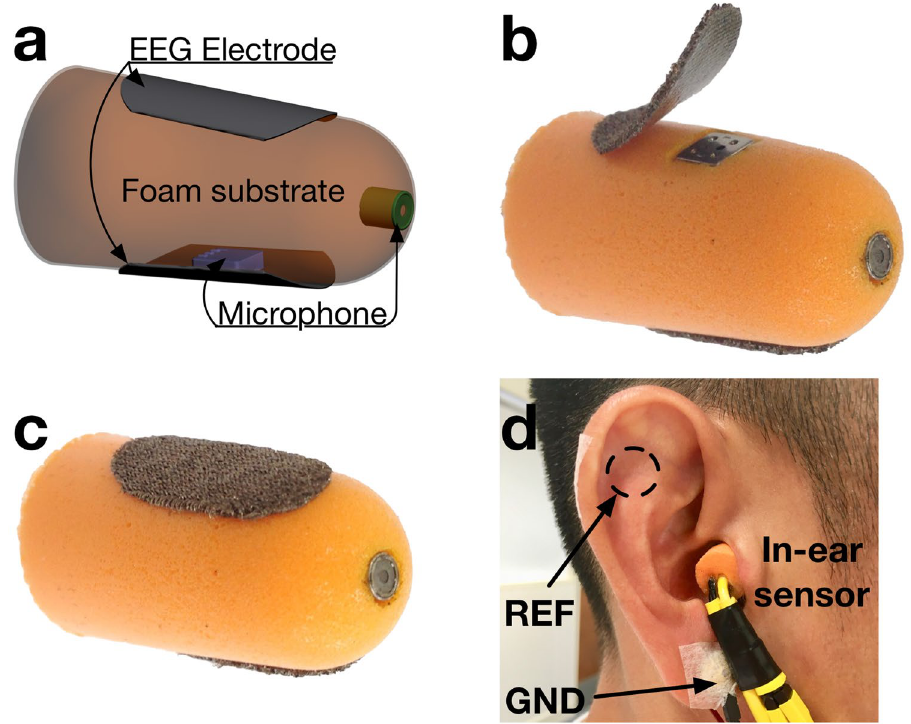
Figure 1. Construction of the multimodal in-ear sensing device. ( a ) Detailed structure of the device, showing the placement of the microphone and the electrode on the substrate. ( b ) Construction of the multimodal sensor underneath one of the cloth electrodes. ( c ) Completed earpiece with electrodes and inward-facing microphone visible. ( d ) Placement of the earpiece in the user’s